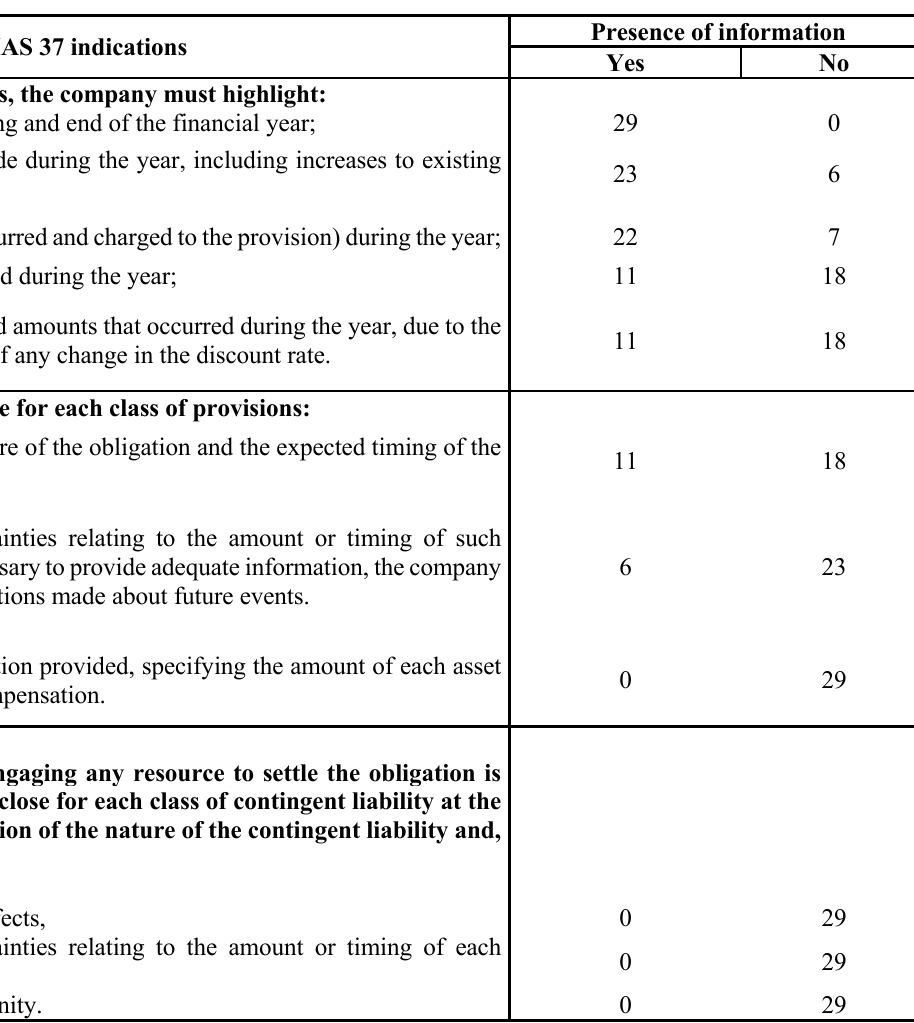
Table 2. Summary of empirical evidence of disclosure for cost decommissioning: Italy checklist